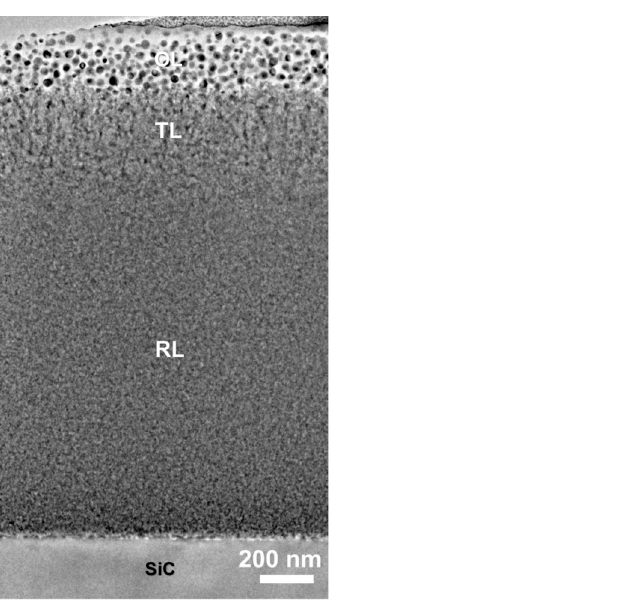
Figure 8. Cross-section TEM image of the Hf 7 B 10 Si 32 C 2 N 44 film annealed up to 1500 °C in air.